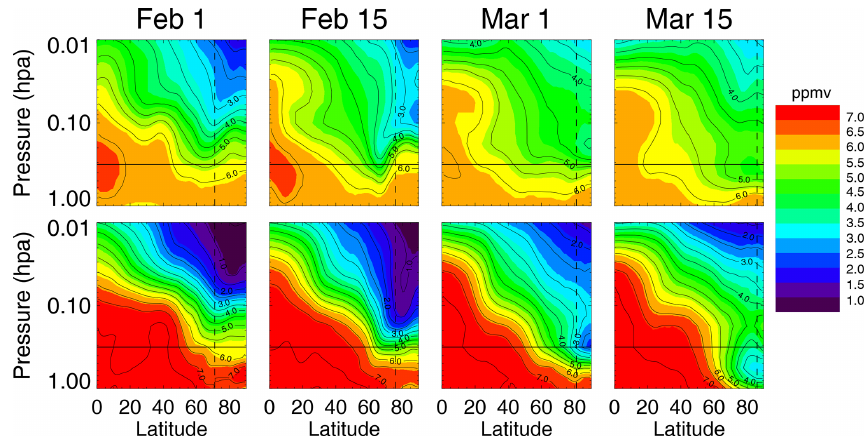
Figure 5. Daily and zonally averaged H 2 O from WACCMX (top row) and NAVGEM-HA (bottom row) for the indicated dates. The horizontal line in each panel is a fiducial to mark the 0.32hPa level. The vertical dashed lines mark the latitude of the SOFIE occultations for each date.